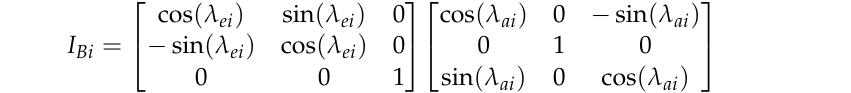
Table 1. Transformation angles from BCS B to SCS I